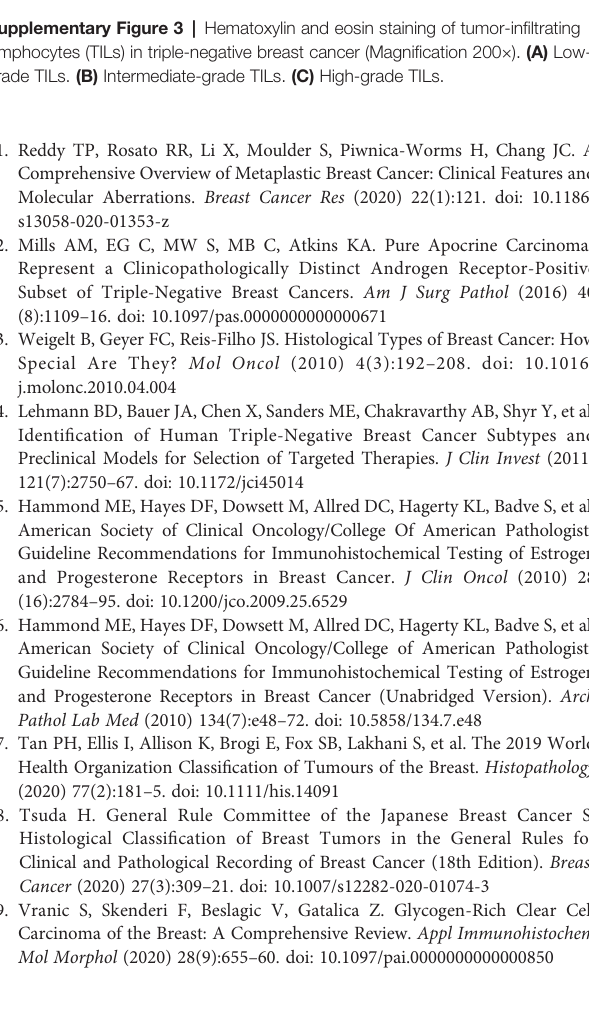
Supplementary Figure 1 | Kaplan-Meier survival curves based on no-special type in fi ltrating ductal carcinoma and special types of triple negative breast cancer patients. (A) Disease free status of patients in the Cancer Genome Atlas cohort. (B) All patients in the Cancer Genome Atlas cohort. (C) All patients in the Molecular Taxonomy of Breast Cancer International Consortium cohort. Supplementary Figure 2 | Immunohistochemical staining of programmed death- ligand 1(PD-L1) in triple- negative breast cancer (Magni fi cation 200×). (A) Negative control of PD-L1 expression by immunohistochemistry. (B) Low PD-L1 expression intriple-negative breastcancertumorsamples. (C) HighPD-L1expressionin triple- negative breast cancer tumor samples. Supplementary Figure 3 | Hematoxylin and eosin staining of tumor-in fi ltrating lymphocytes (TILs) in triple-negative breast cancer (Magni fi cation 200×). (A) Low- grade TILs. (B) Intermediate-grade TILs. (C) High-grade